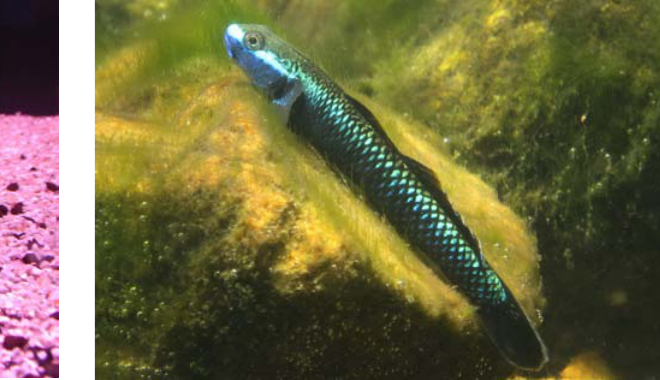
Image 2. Stiphodon atropurpureus